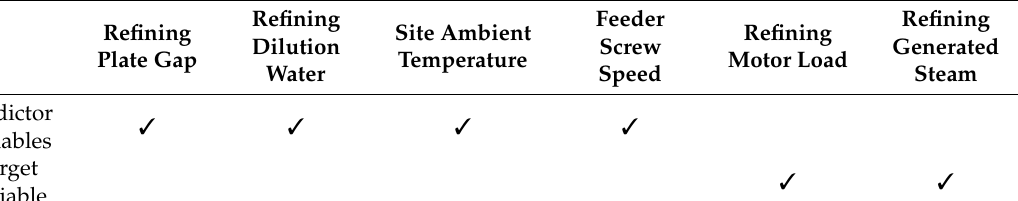
Table 1. Artificial neural network (ANN) model input and target variables.